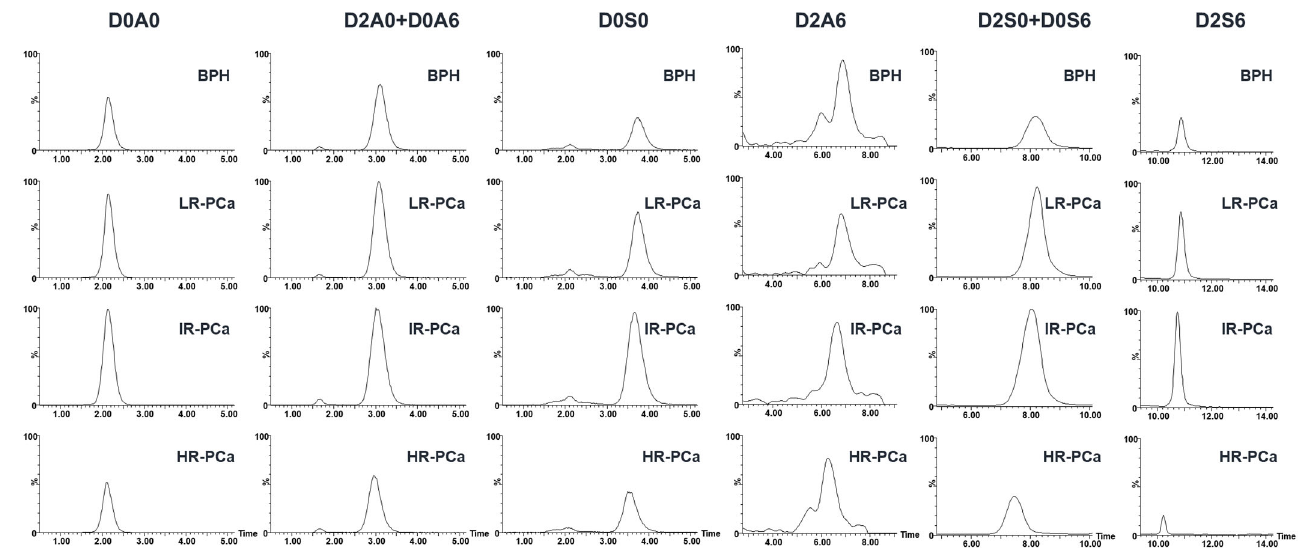
Figure A2. Representative extracted ion chromatograms of HS disaccharide measurements. See Figure 1 for resolving the GAG structure codes.